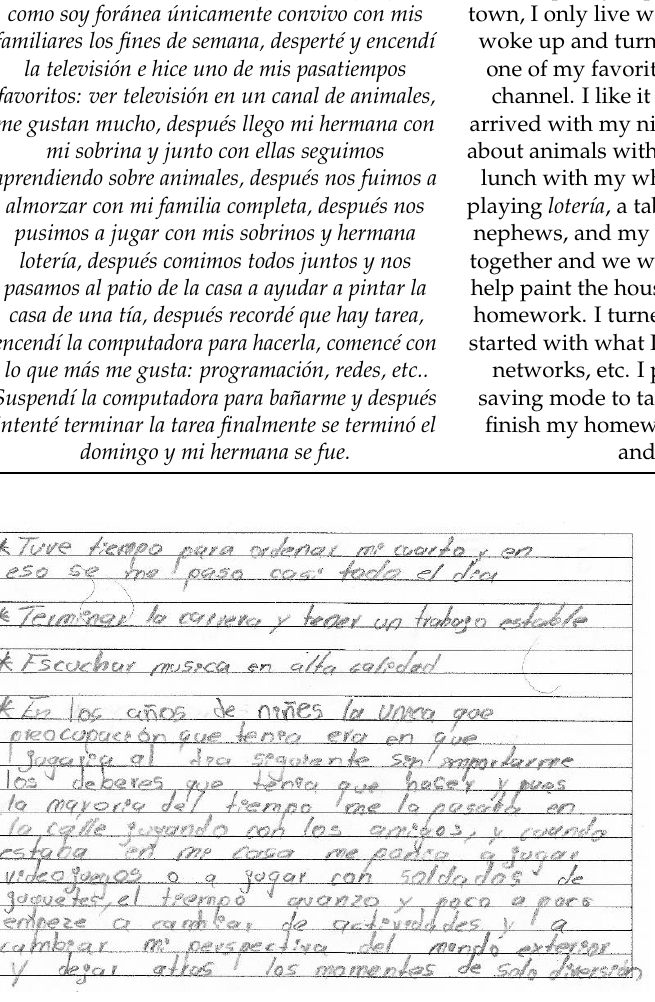
Figure 2. Example of a handwritten